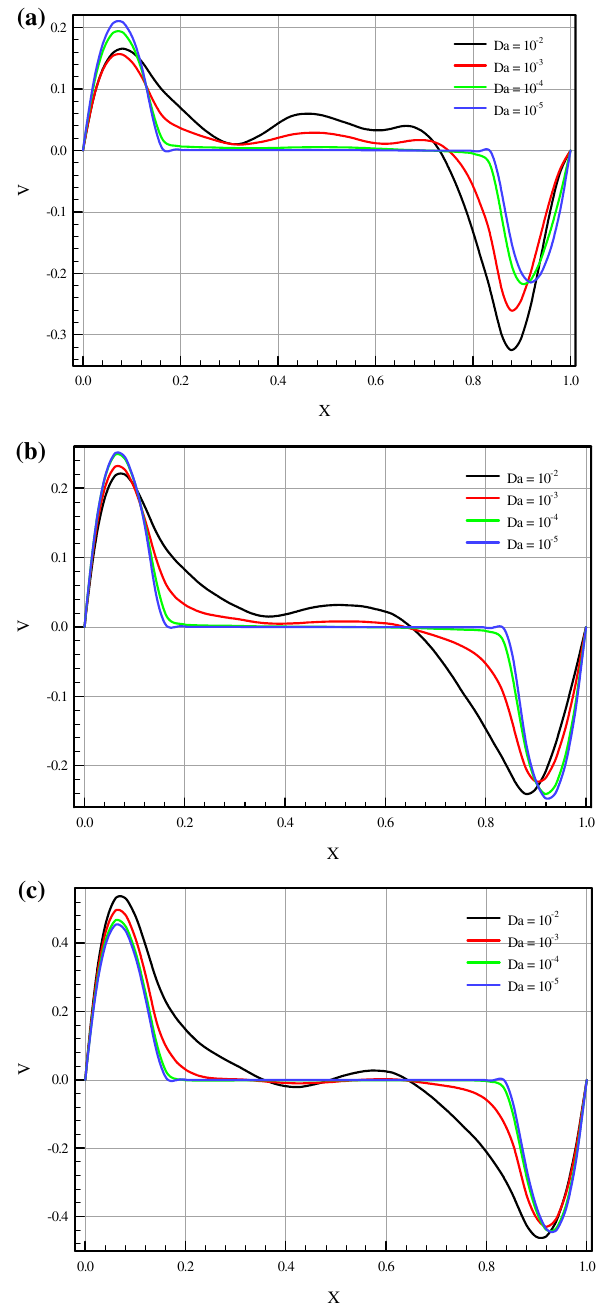
Figure 7. ( a ) Effect of different Darcy number on vertical velocity for τ = 0.1, Effect of different Darcy number on vertical velocity for τ = 0.1, Darcy number on vertical velocity for τ = 0.1,